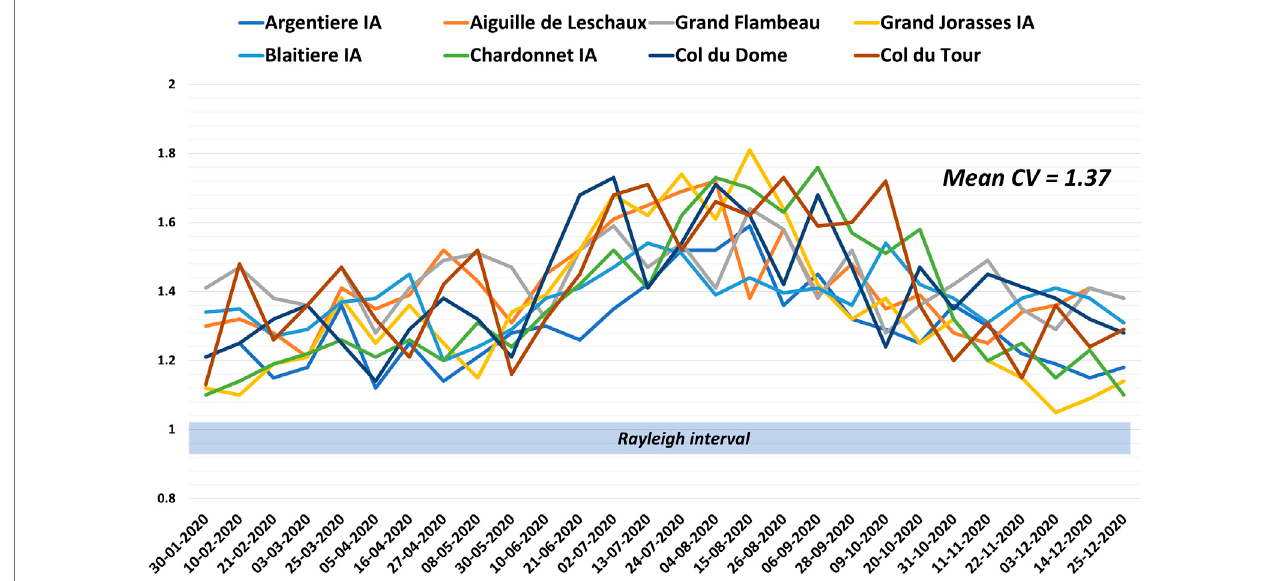
FIGURE 10 | Annual evolution of the spatial coef fi cient of variation for 8 IAs using PAZ images.